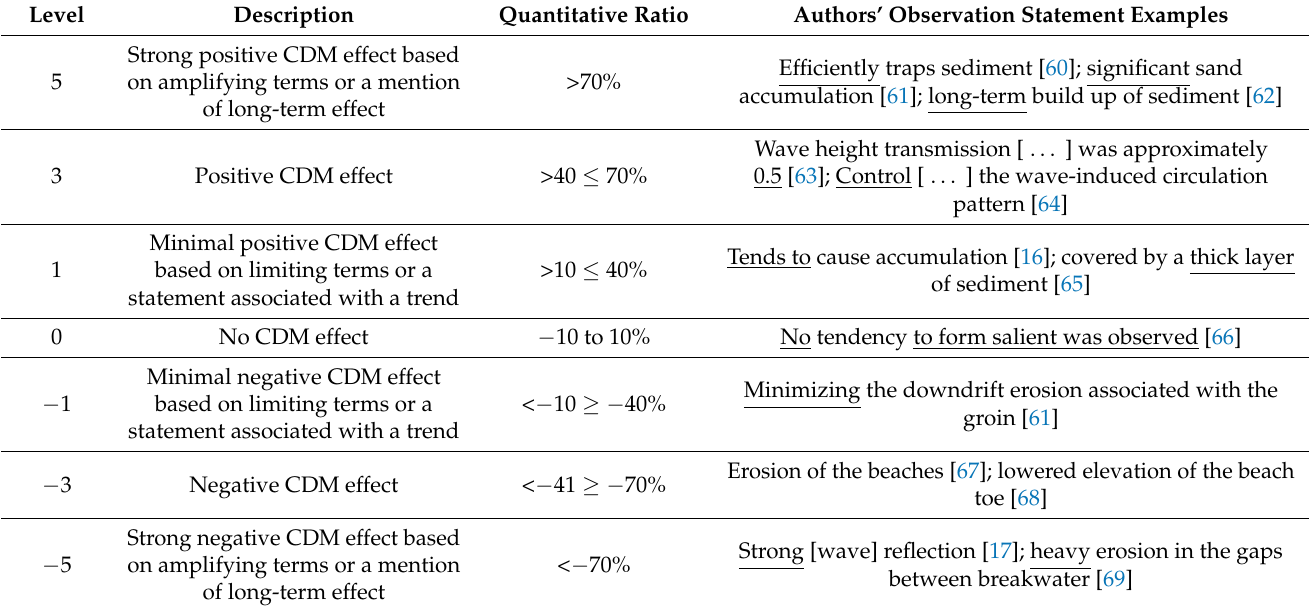
Table 6. Weighting scale used for the evaluation of authors’ observation